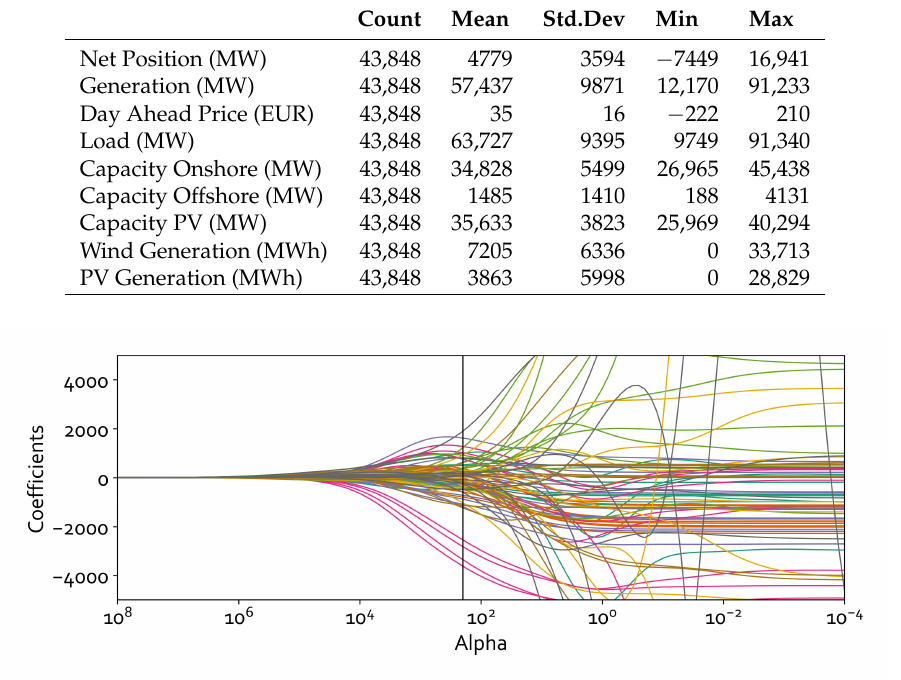
Table A1. Descriptive statistics of input data.